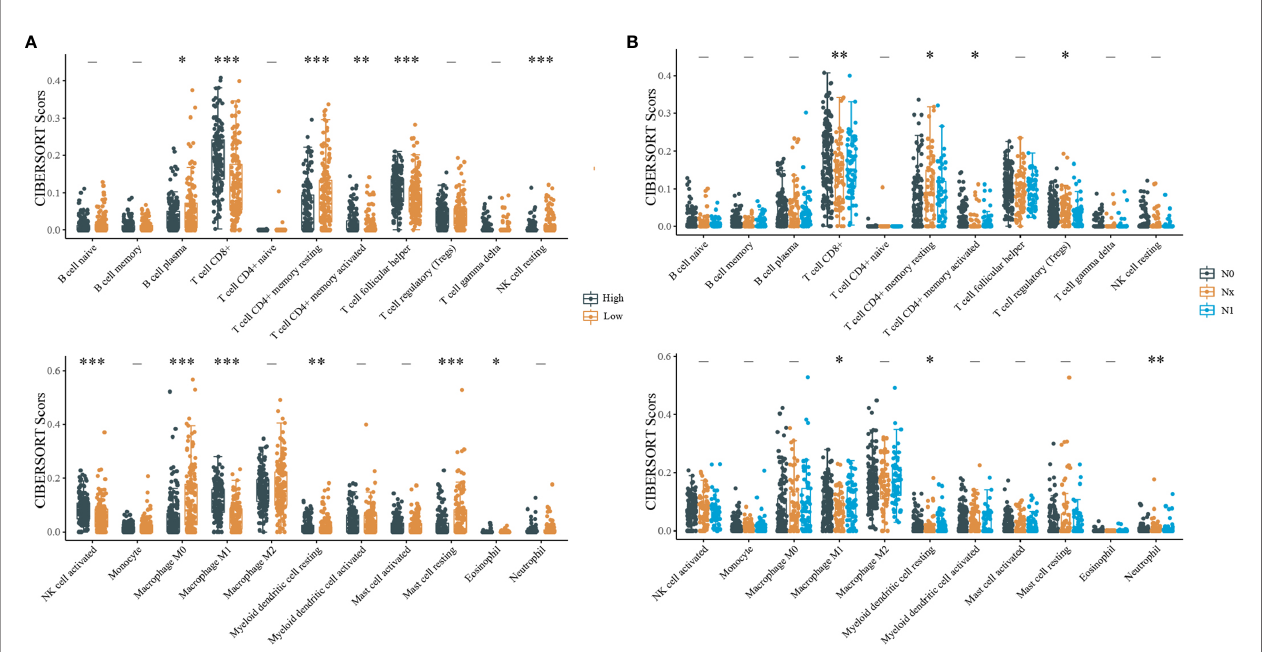
FIGURE 4 | CIBERSORT statistics of relative proportions of immune cell subpopulations. [ (A) Distribution of immune scores for different IDO1 expression level; (B) Distribution of immune scores for different N stages; “ - ” P > 0.05, *P < 0.05, **P < 0.01, ***P < 0.001].